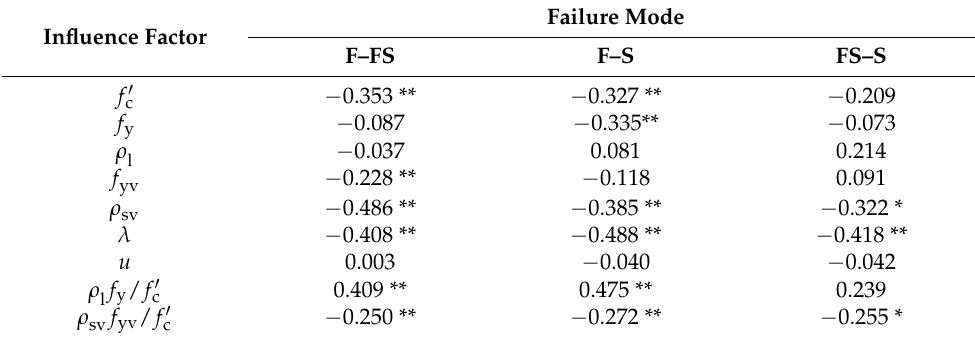
Table 2. Pearson correlation coefficients between factors and failure modes.